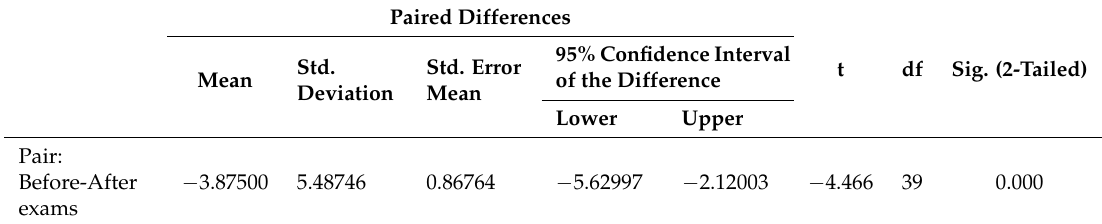
Table 4. Paired Samples